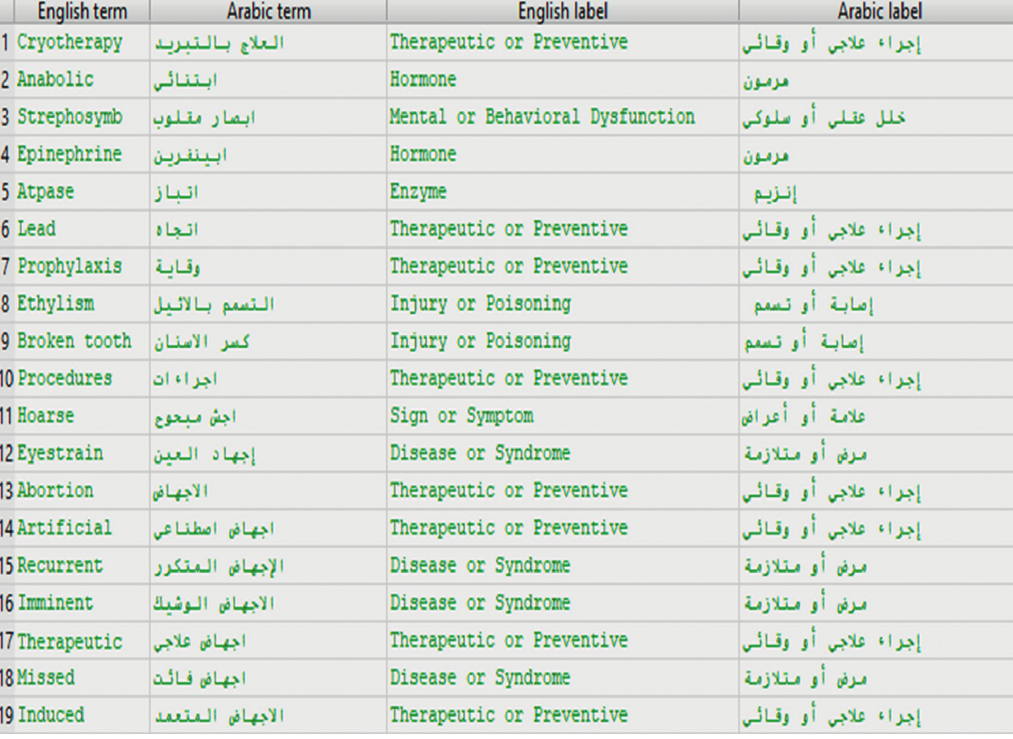
Figure 2: A sample of annotated bilingual medical